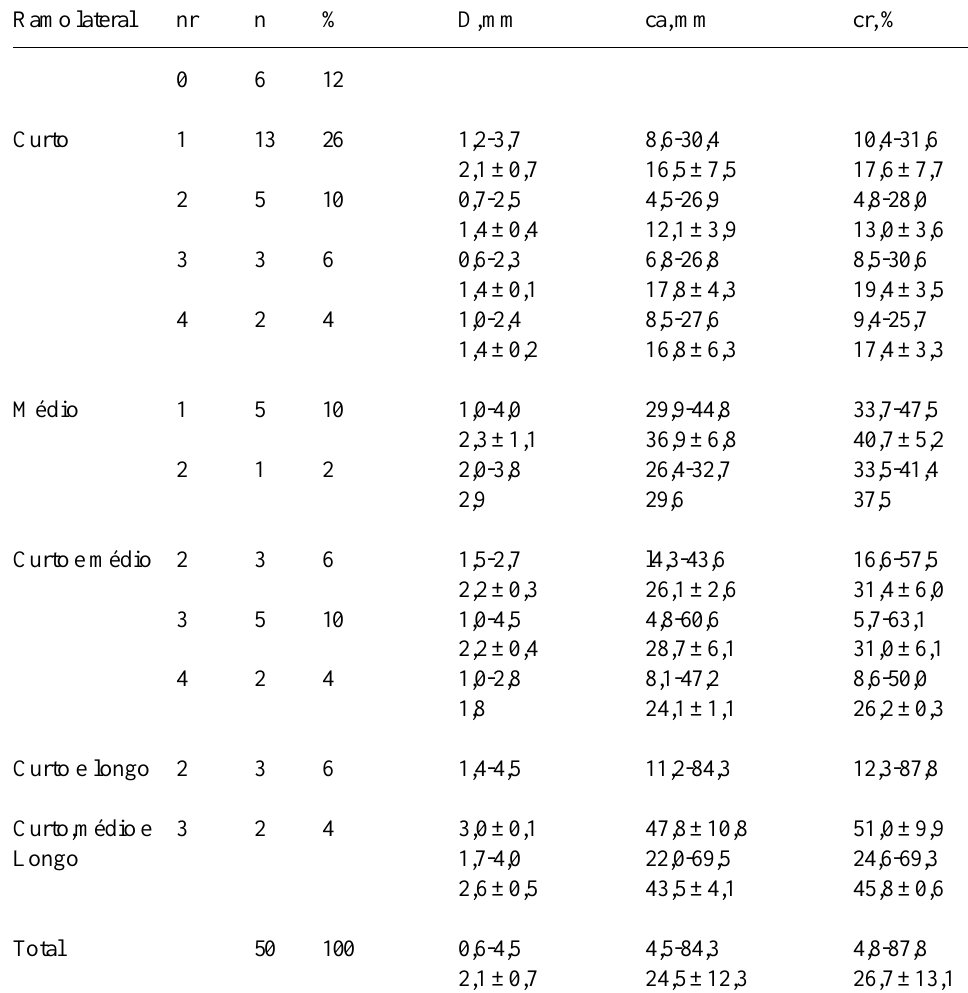
Tabela 3. Distribuição da freqüência, do número de ramos, do diâmetro e dos comprimentos absoluto e relativo do ramo lateral, conforme o